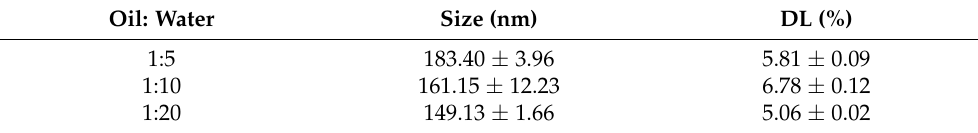
Table 3. Effect of the ratio of oil to water on DL.